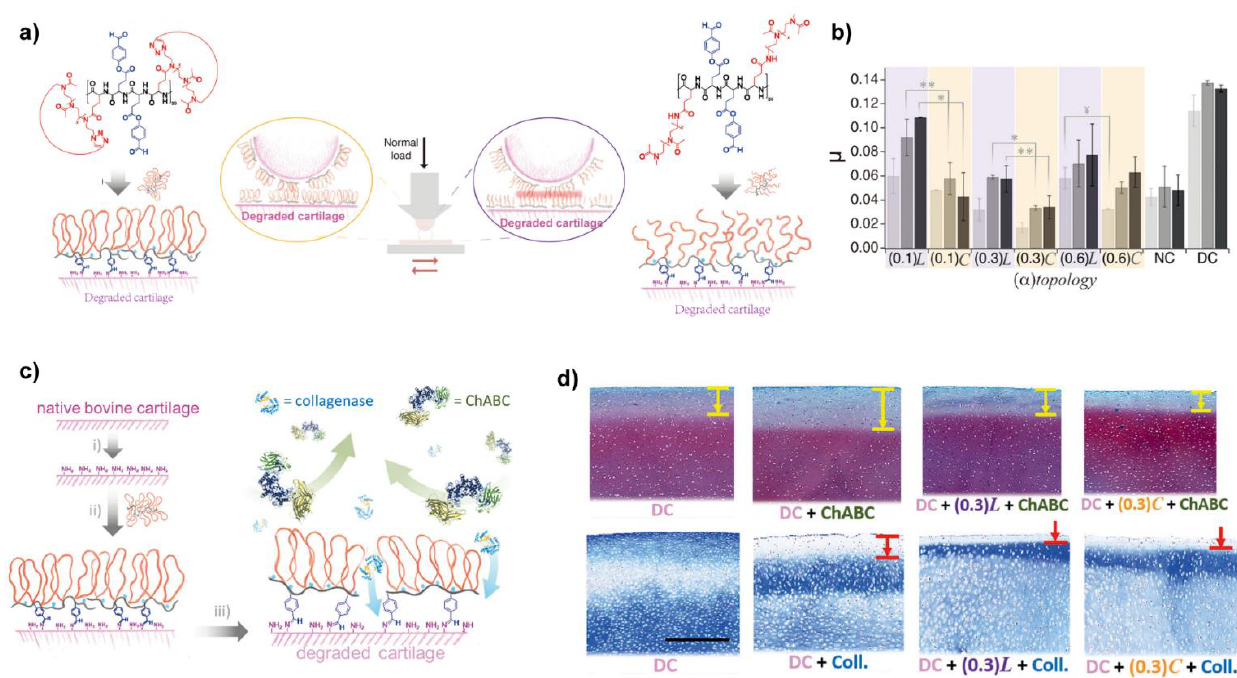
Figure 6. ( a ) Comparison of the chemical structure of the PGA-LPMOXA-HBA and PGA-CPMOXA-HBA and their schematic adsorption on the degraded cartilage; ( b ) The lubricating abilities of PGA-LPMOXA-HBA and PGA-CPMOXA-HBA with series of partial of PMOXA using degraded cartilage (DC) and normal cartilage (NC) under different pressures (light gray, 0.5 MPa; gray, 0.7 MPa; dark gray, 0.9 MPa). The friction coefficients were significantly reduced when replaced the LPMOXA by CPMOXA. (**) p<0.05; (*) p<0.01; ( # ) p=0.05; ( ¥ ) p=0.095; ( c ) Schematics of the derived lubrication film formed by PGA-CPMOXA-HBA protected the cartilage from enzymatic degradation. i) ChABC (1 U/mL, 0.01 % BSA in PBS), 1 hour, 37 ℃ ; ii) 0.1 mg/ mL PGA-( α ) CPMOXA-HBA in HEPES II, overnight; iii) ChABC (1 U/mL, 0.01% BSA in PBS), 1 hour, 37 ℃ or collagenase (1.2 mg/mL in PBS), half an hour, 37 ℃ ; ( d ) Safranin-O staining treated by PGA-LPMOXA-HBA (0.3 L) and PGA-CPMOXA-HBA (0.3 C). The arrows indicated the enzyme-penetrated depth. Scale bar, 500 μm. Reprinted with permission from ref. [103]. Copyright 2018 Wiley-VCH.